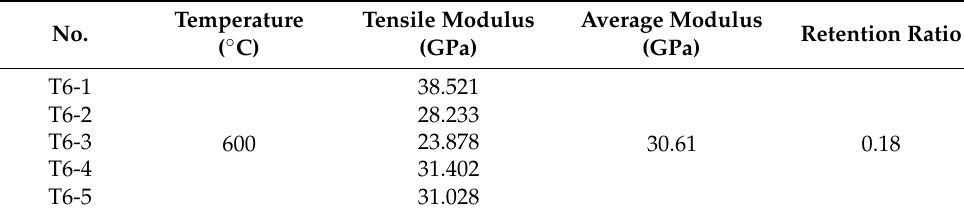
Figure 6. Variety curve of strength with temperature.